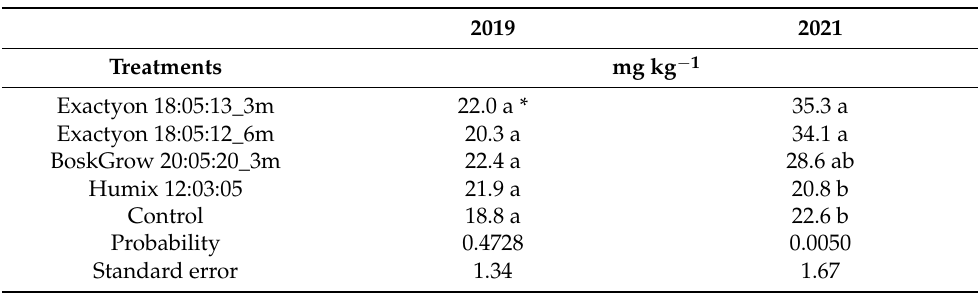
Table 2. Boron concentration in the chestnut shells (pericarps) from the harvests of 2019 and 2021 as a function of the fertilization treatments.